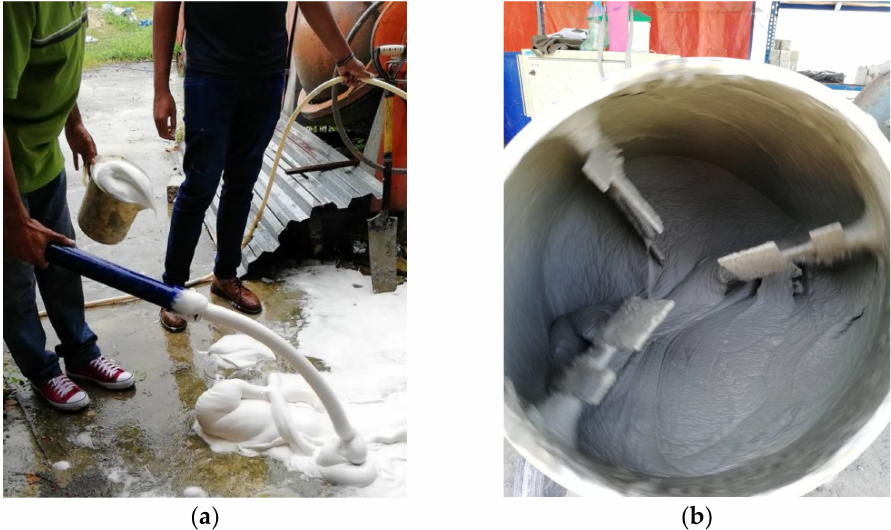
Figure 1. Preparation of LFC mixture. ( a ) stable foam; ( b ) uniform LFC